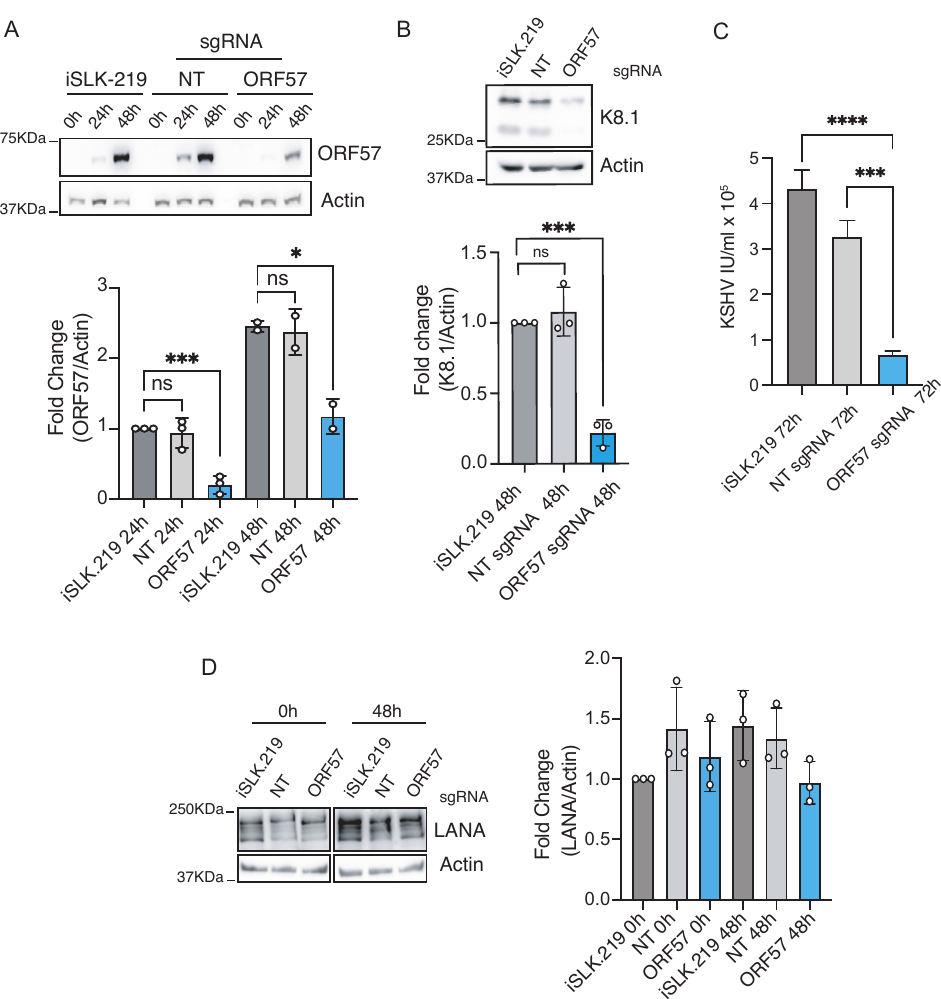
Figure 4. CRISPRi silencing of immediate–early genes in iSLK-219 cells. Immunoblot analysis of ( A ) ORF57 (one-way ANOVA, 24 h **** p < 0.001, 48 h * p value 0.025), ( B ) K8.1 (one-way ANOVA, 48 h *** p < 0.001) and ( D ) LANA (Kruskal–Wallis test, 0.99 < p < 0.3) in latent and lytic (24 and 48 h post-reactivation) iSLK-219 cells, and iSLK-219-dC9K cells transduced with a non-targeting (NT) sgRNA or an ORF57-specific sgRNA. Image representative of three biological replicates. Bars: quantification of the data. Error bars: standard deviation, ns, not significant. ( C ) Quantification of viral titers (IU, infectious units) in the filtered supernatant of iSLK-219 or iSLK-219-dC9K cells transduced with a non-targeting (NT) sgRNA or an ORF57-specific sgRNA, collected at 72 h post- reactivation. Error bars: standard deviation. (one-way ANOVA, **** p < 0.001, *** p <